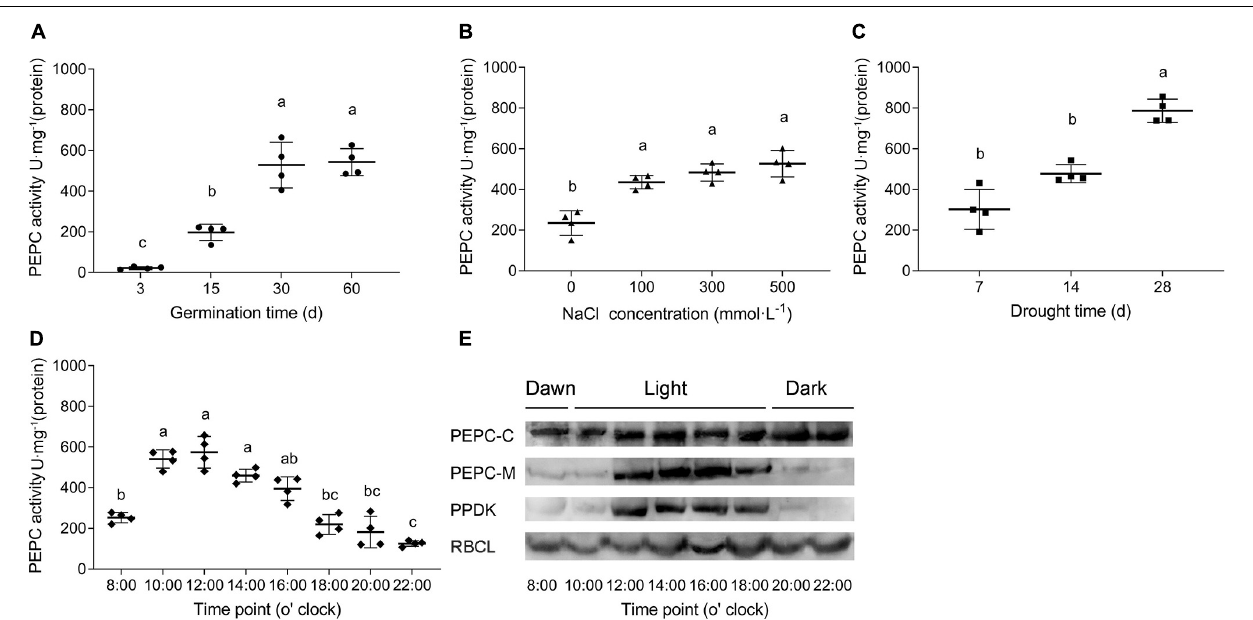
FIGURE 9 | PEPC activity in S. aralocaspica leaves under various treatments. (A) Different developmental stages of seedlings; (B) NaCl stress; (C) Natural drought stress (days of withholding water); (D) Activity variations within a whole day; (E) Variations of protein amounts of key photosynthetic enzymes. PEPC-C, total PEPC; PEPC-M, phosphorylated PEPC; RBCL, Rubisco large subunit. Different lowercase letters indicate significant difference at different treatments. Values are means ± SD of four replicates.